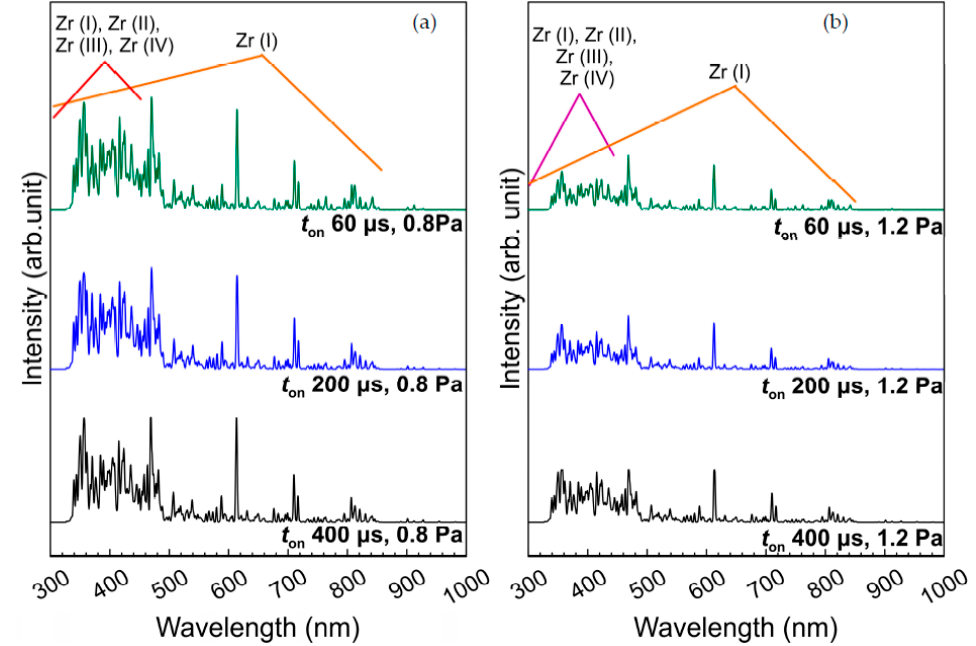
Figure 10. Optical emission spectra of the HiPIMS discharge of different pulse widths at the argon pressure of ( a ) 0.8 Pa and ( b ) 1.2 Pa. ( b ) 1.2